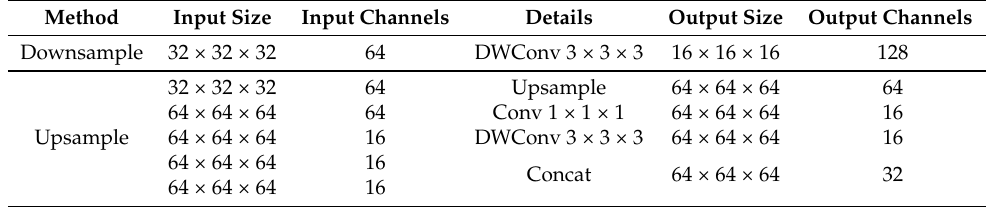
Table 3. The structure of LRMF module.